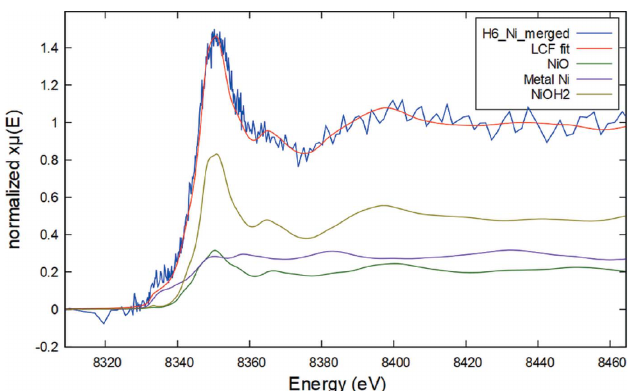
Figure 2 An example of a fit obtained through LCF analysis on the merged XANES spectrum of sample H6 (blue line), using 29.1% Ni metal foil (violet line), 21.6% NiO (green line) and 49.3% Ni(OH) 2 (beige line) reference compounds.